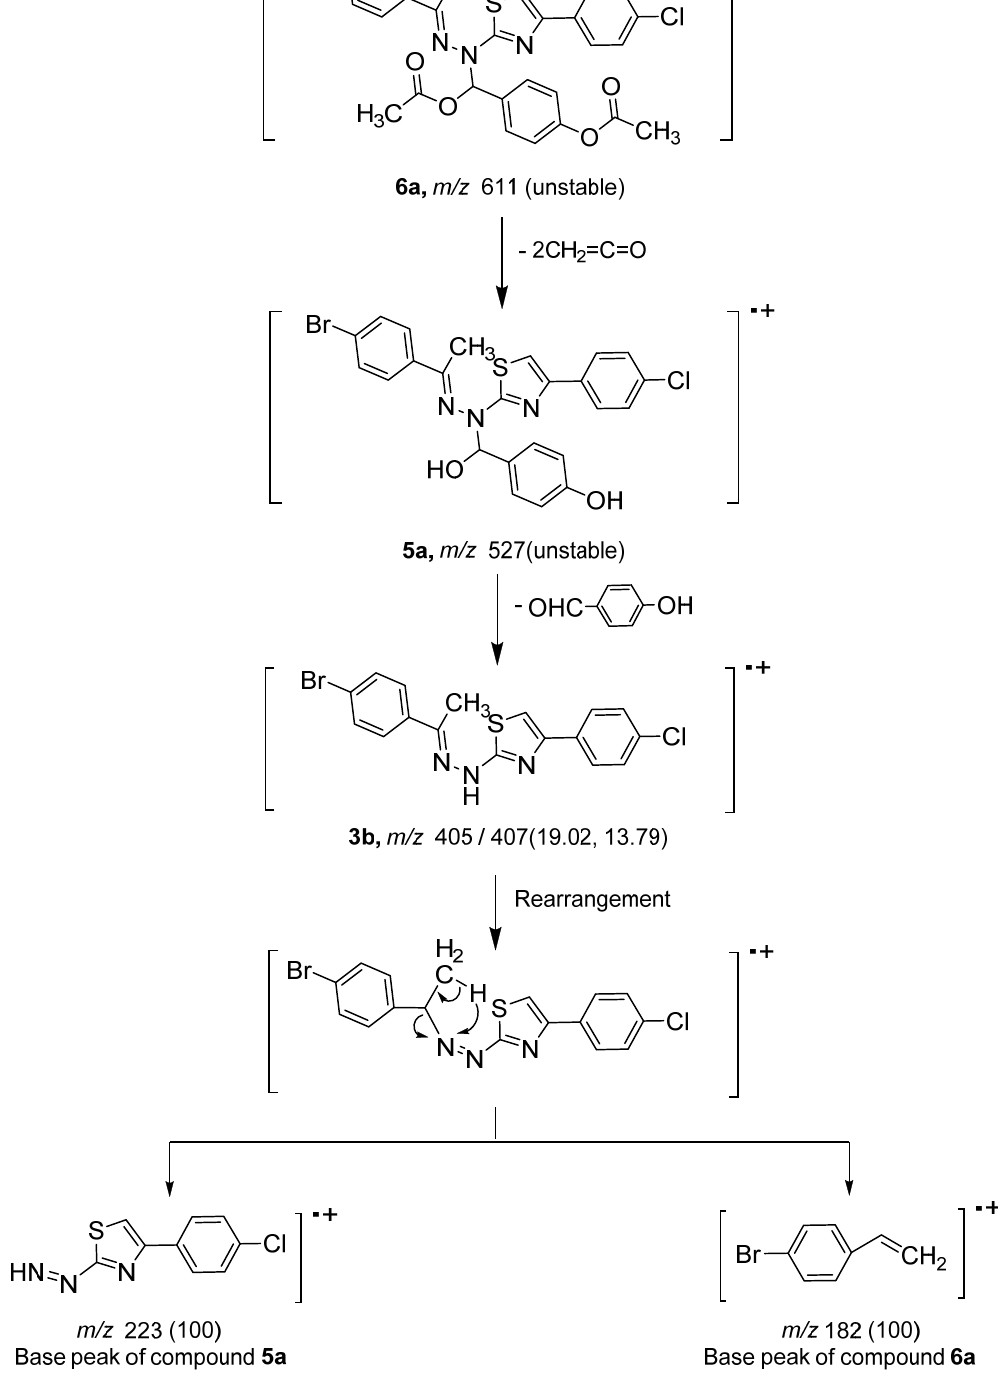
Scheme 5. The represented mass fragmentation pattern of compounds 5a and